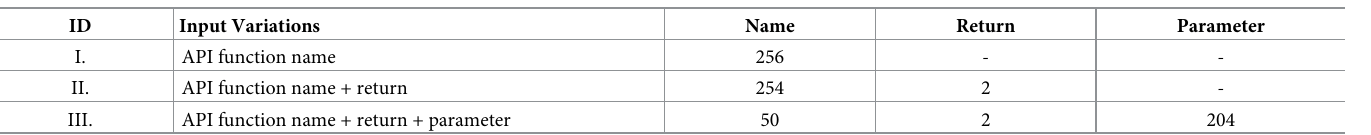
Table 5. Embedding sizes for three